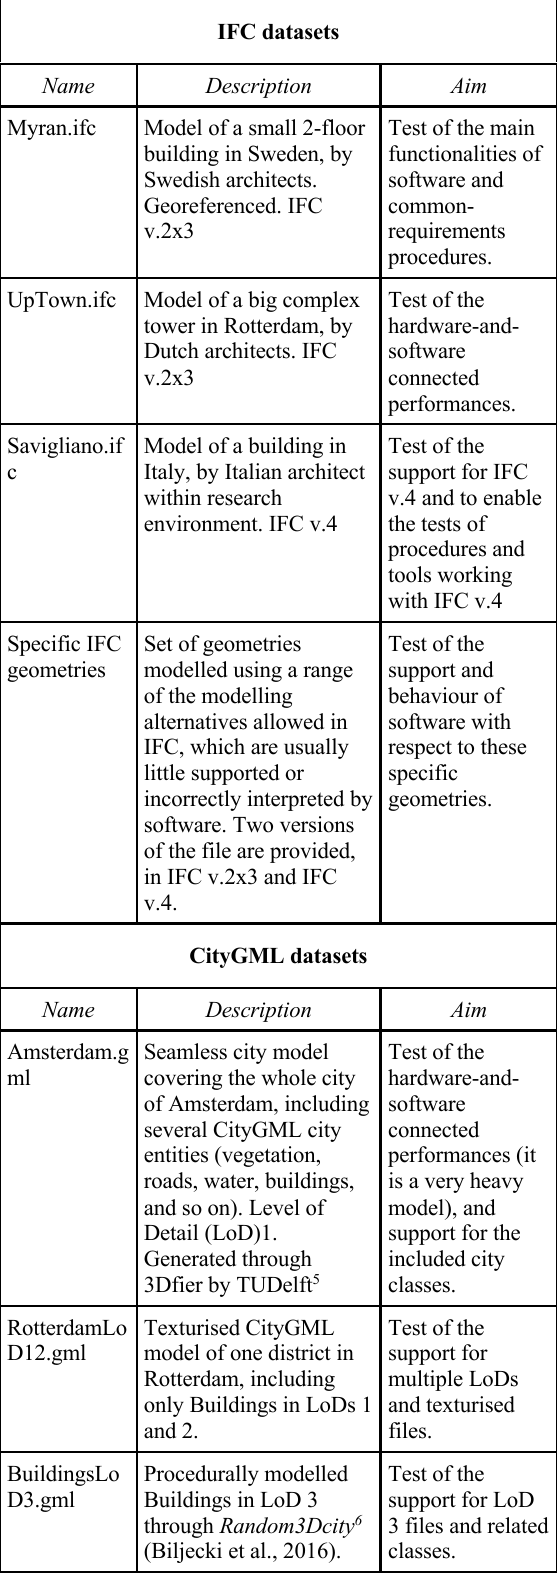
Table 1. Summary of the provided datasets for the